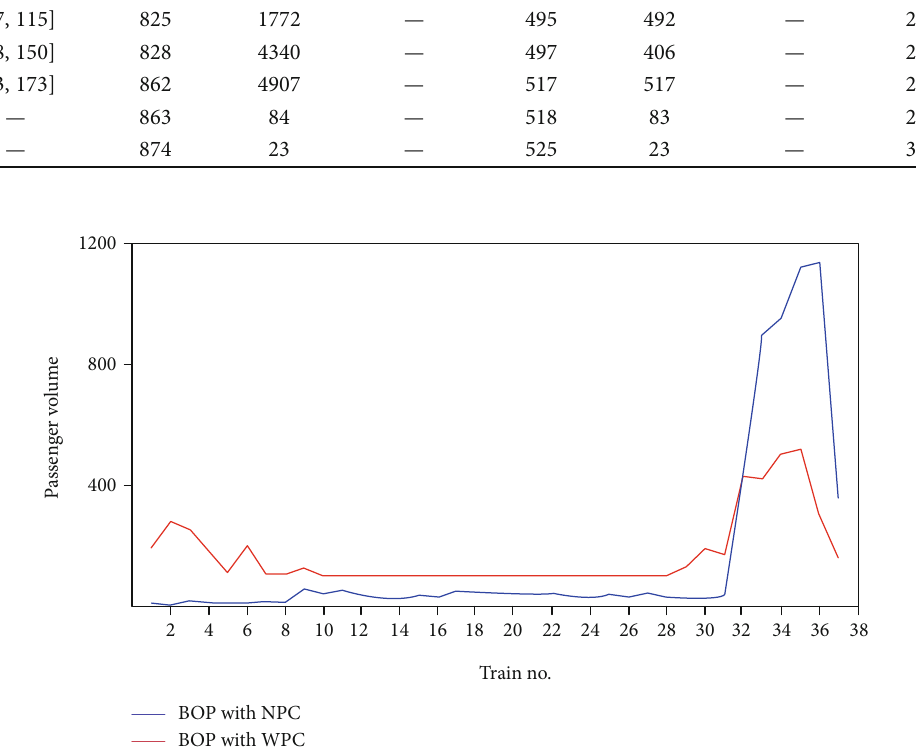
Figure 7: Boarding passengers at CU